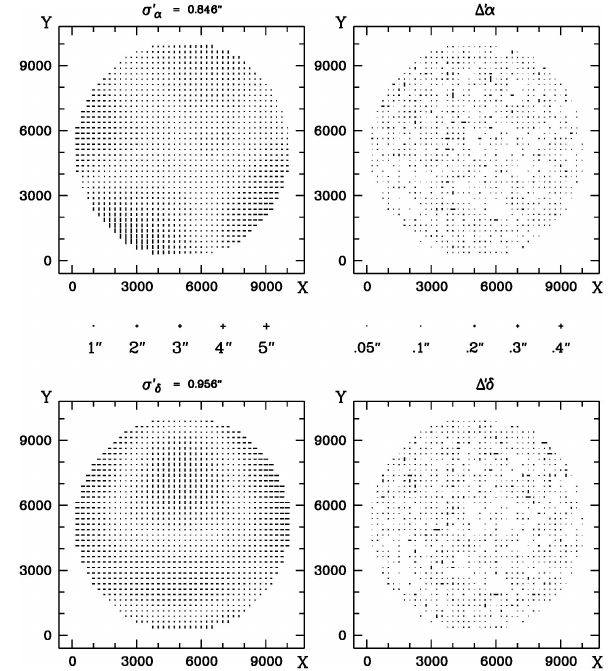
Figure 3. The processing results of the plate No. 16036. On the left systematic errors of alpha and delta along the field of the plate before corrections, on the right is the residual differences (random errors)alpha and delta for the counted and catalog values of the equatorial